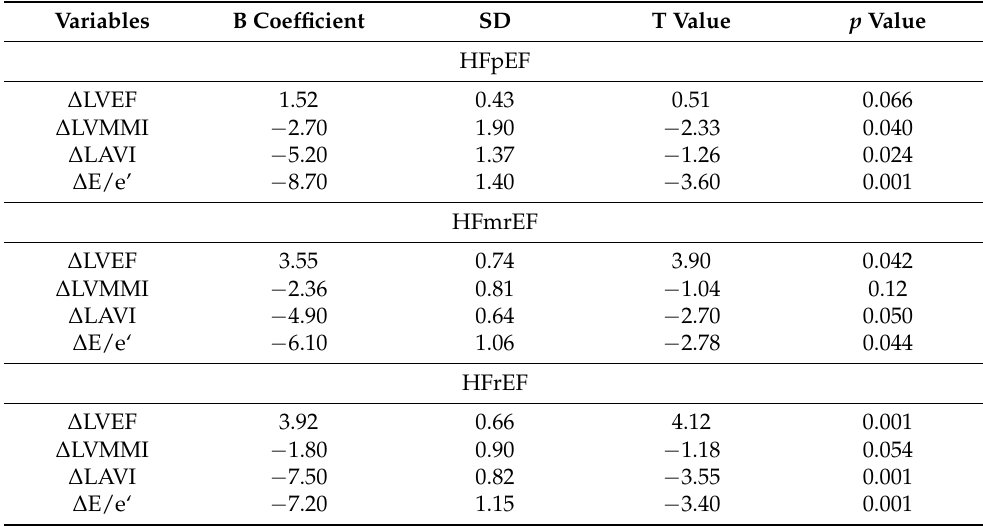
Table 4. Multiple regression analysis for the association of apelin levels after administration of dapagliflozin depending of phenotypes of